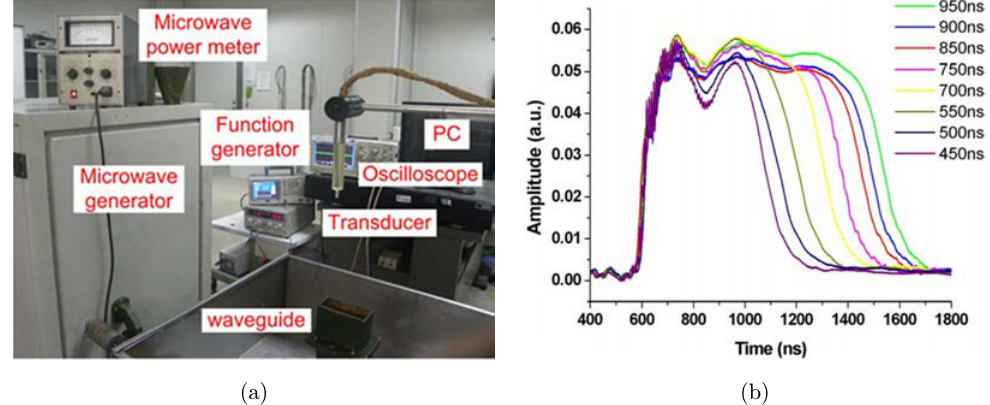
Fig. 2. (a) A typical microwave generator working in the waveguide mode. 92 (b) Several pulse widths of this microwave generator. 86